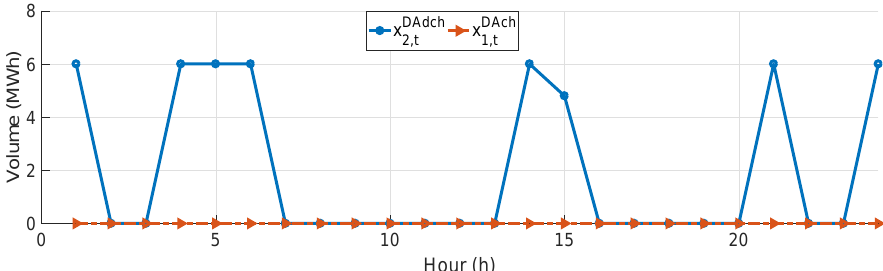
Figure 5. The optimal coordinated bidding in the day-ahead market for four iterations of rolling planning ( χ =